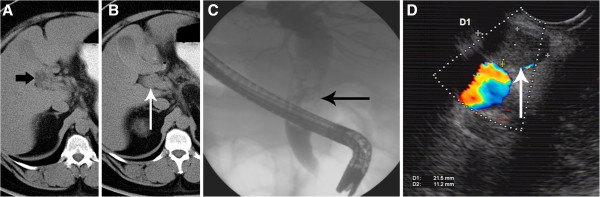
Radiographic findings of the pyloric gland adenoma of the cystic duct. Abdominal computed tomography revealed markedly dilated intrahepatic bile ducts (A, arrow), and a polypoid tumour in the common hepatic duct just below the bifurcation (B, arrow). Endoscopic retrograde cholangiopancreatography confirmed the polypoid mass lesion (C, arrow) and demonstrated consecutive dilation of the central intrahepatic bile ducts. Endosonography verified the polypoid intraluminal tumour of 2.1 x 1.1 cm in the common hepatic duct (D, arrow) next to the portal vein.